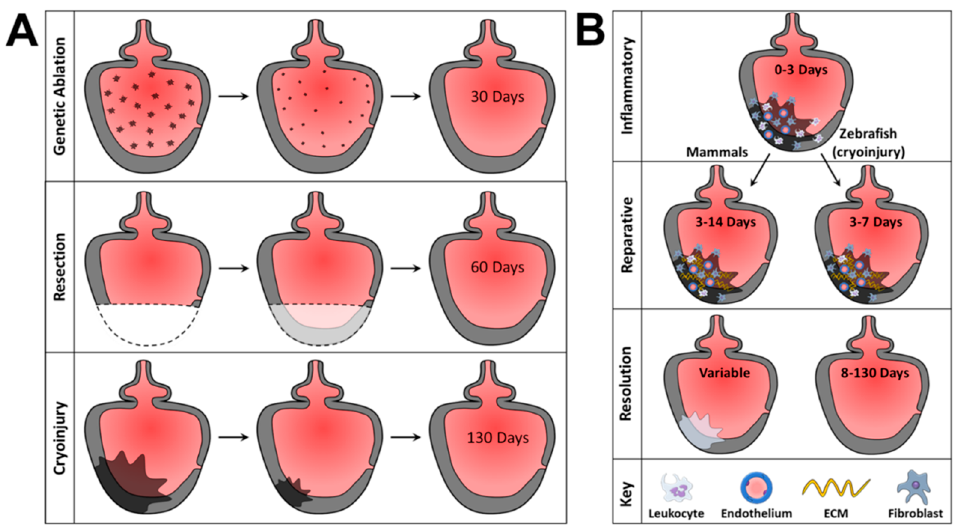
Figure 2. Damage patterns in MI models and MI wound repair process. ( A ) Representations of zebrafish MI models and their damage patterns. Genetic ablation targets only myocardium and is resolved in 30 days. Resection models are transmural but remove tissue that would otherwise require cellular debridement and cause extracellular matrix (ECM) protein deposition that is inconsistent with mammalian MI. Resection injury resolves in 60 days. Cryoinjury is a transmural injury model that closely resembles mammalian MI, requiring cellular debridement and showing ECM protein composition and deposition patterns like those observed in mammalian MI. ( B ) Stages of wound repair in mammalian and zebrafish cryoinjury MI by stage. The inflammatory stage lasts from 0 to 3 days of injury and is characterized by inflammatory cell recruitment and inflammatory responses governed by the innate immune system. The reparative phase lasts 3–14 days in mammals or 3–7 days in zebrafish cryoinjury models. During this stage, ECM deposition provides a scaffolding for wound resolution. Wound resolution ends with characteristic loss of cardiomyocytes, scarring, and decreased cardiac function in mammals, while zebrafish can regenerate lost cardiomyocytes from cryoinjury within 130 days of injury.